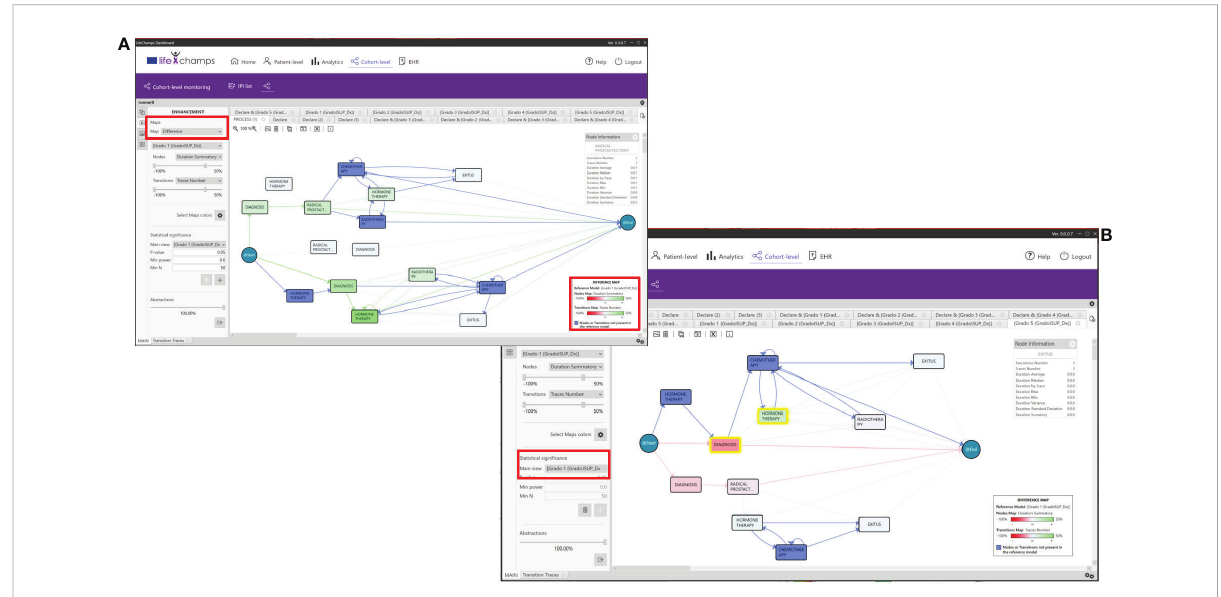
FIGURE 6 Differences between groups. (A) IPI showing the differences between the concrete Gleason Group 1 and all the patients and where the differences lie. Greener color in nodes, as opposed to red, represents higher difference in time spent in median in that stage, while the reddest color in transitions means larger difference in the number of cases in that transition. (B) IPI showing the statistical signi fi cance between Gleason Grade Groups 1 and 5. Nodes highlighted in yellow represent where the difference is statistically signi fi